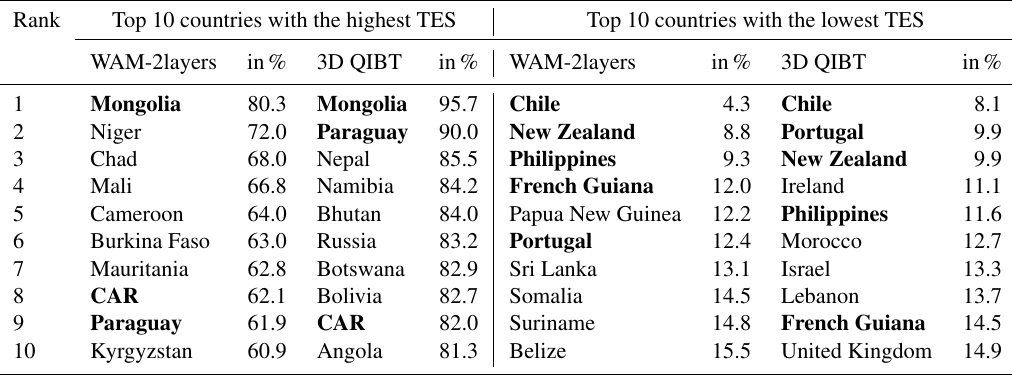
Table 5. Comparison of the top 10 countries with the highest and lowest average TES values between our dataset based on the WAM-2layers method and the one referring to the 3D QIBT method (Dirmeyer et al., 2009). Countries appearing in both lists are displayed in bold font (CAR stands for Central African Republic).